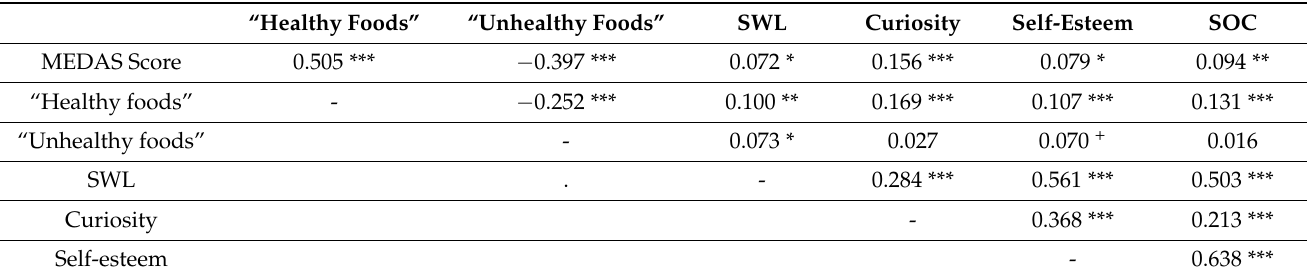
Table 4. Correlation